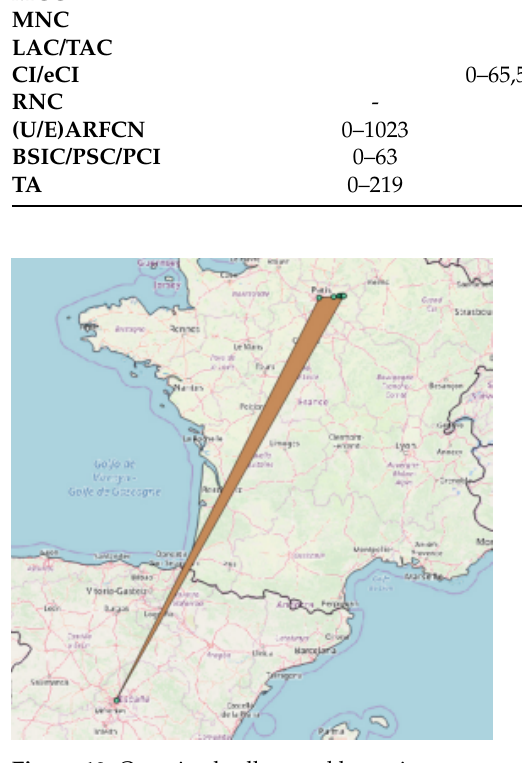
Figure 10. Oversized cell caused by an inter-country faulty